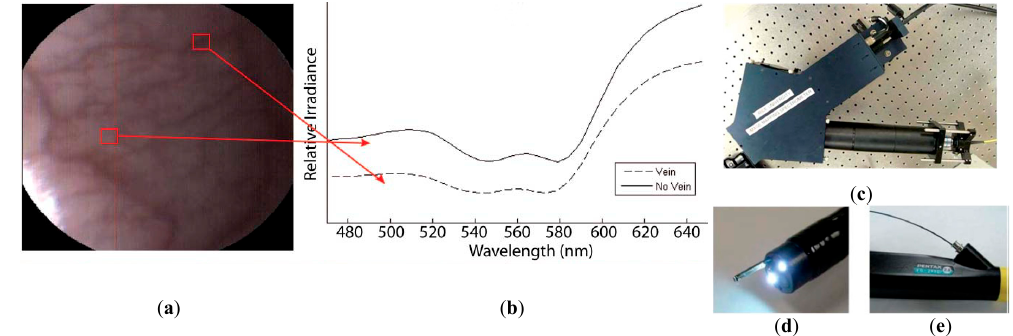
Figure 9. HS image example of the lower lip of a normal human acquired with the image mapping spectroscopy (IMS) endoscope developed in [142]. ( a ) RGB representation; ( b ) Spectral signature of the normal tissue pixel and a vein pixel; ( c ) Clinical setup of the IMS endoscope; ( d ) Miniature imaging end of the IMS endoscope; ( e ) Fiber optics of the IMS endoscope inserted into the instrument channel. Reproduced from [142]; Creative Commons BY 4.0; published by SPIE (2011).